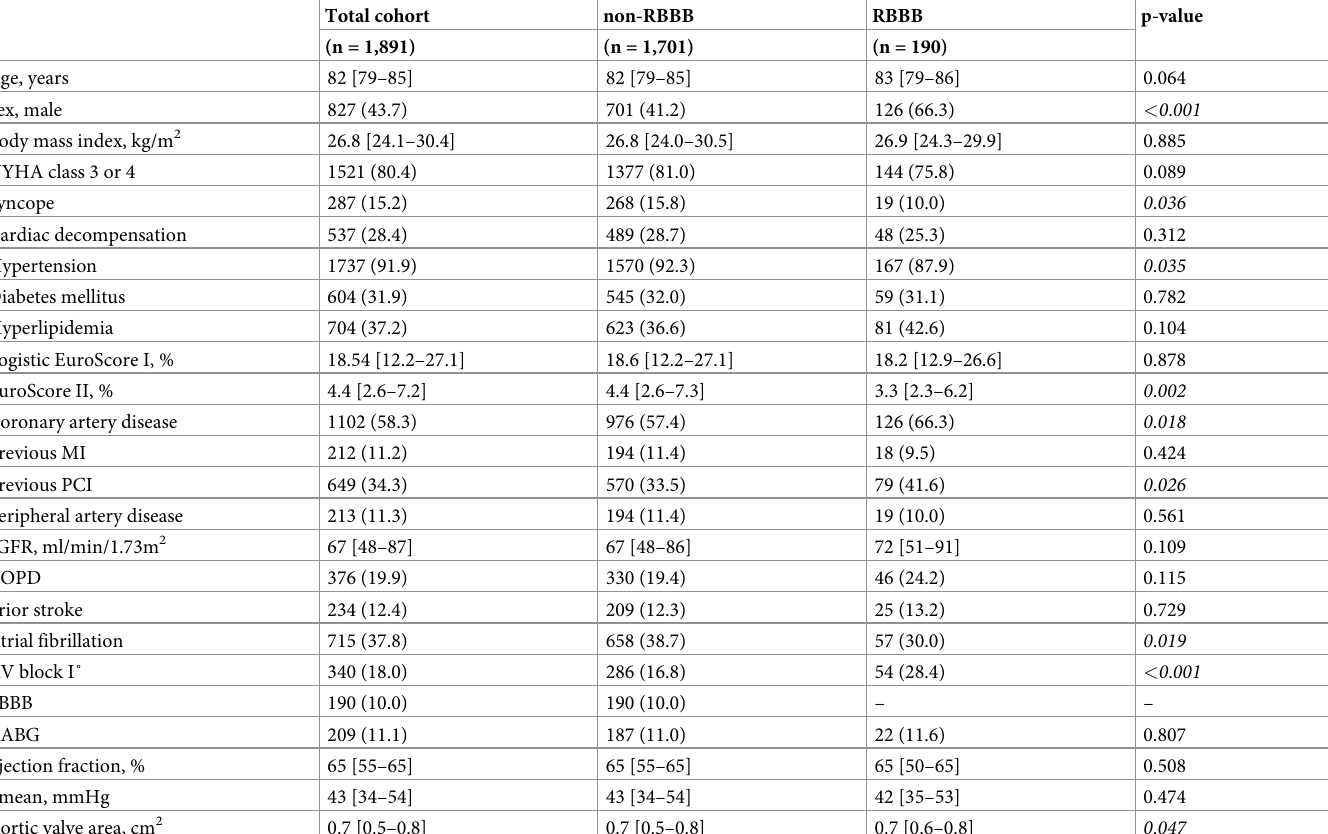
Table 1. Baseline